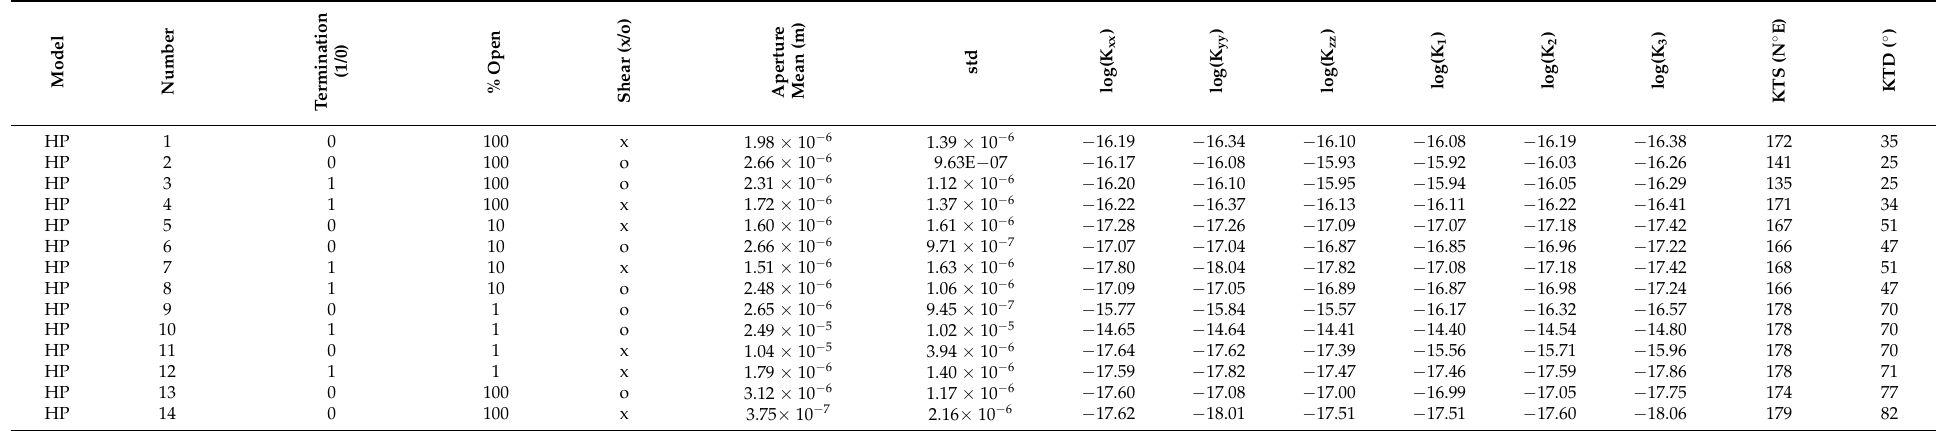
Table 7. Case 2 DFN models aperture and permeability tensor distribution, with K xx , K yy and K zz and permeability tensor magnitudes (K 1 , K 2 and K 3 ), as well as main tensor orientation (KTS, strike and KTD,